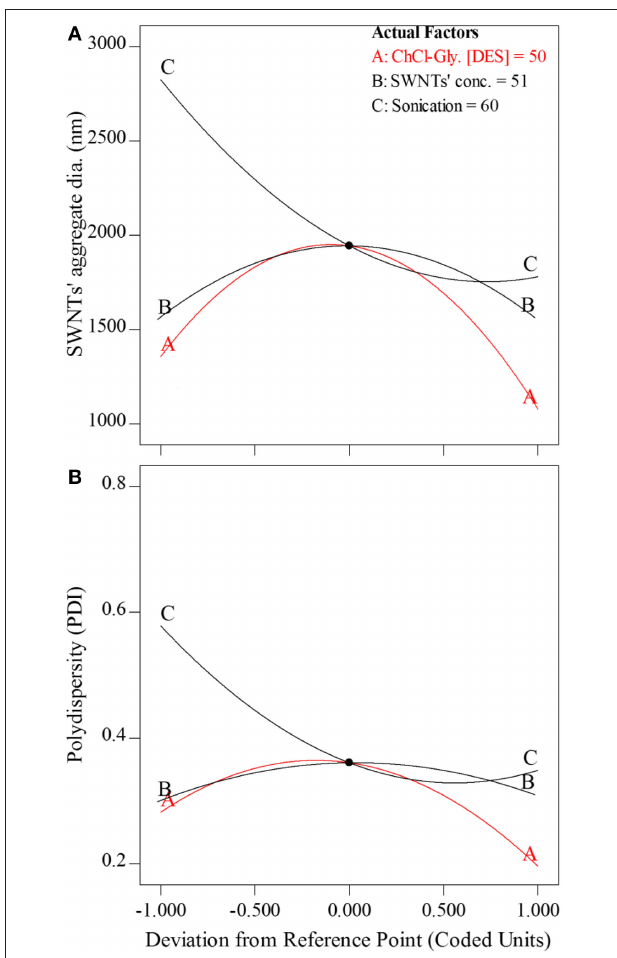
FIGURE 4 | Modeled perturbation plots showing the effect of one variable at a time (while keeping the other two constant) on (A) SWNTs’ aggregate diameter (nm) and (B) polydispersity (PDI) in aqueous ChCl-Gly system. The coded units on the x-axis can be inferred from the experimental values shown in Table 1 . The coded value of 0.0 corresponds to 50% mass of ChCl-Gly, 51 mg/L SWNTs’ concentration, and 60 J/mL sonication energy input to the aqueous DES